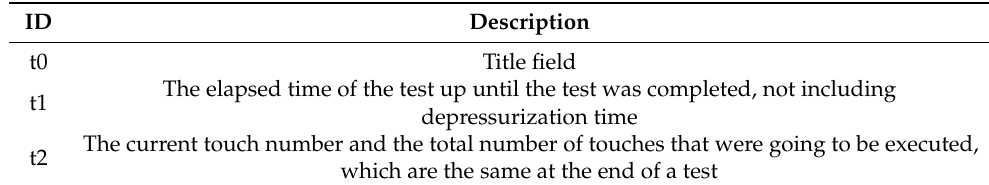
Figure 7. “ Test complete” page.